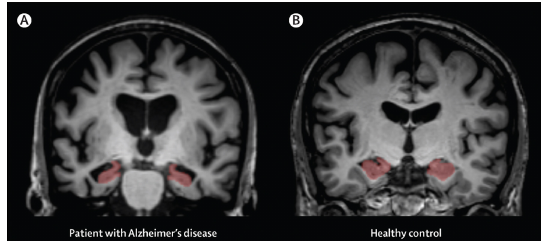
Figure 1. Magnetic Resonance Image (MRI) sample of a healthy person’s brain ( B ) and an Alzheimer’s patient’s one ( A )